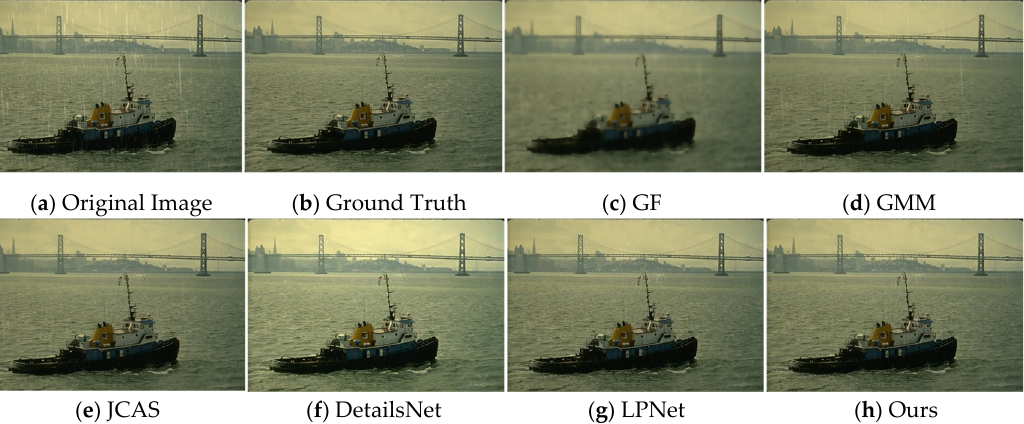
Figure 6. The subjective visual effects of the synthetic image ( “ ship ” ) are compared in total. The first image is the synthetic rain image, the second image is the ground truth, and the following images are the results of GF, GMM, JCAS, DetailsNet, LPNet, and our method.